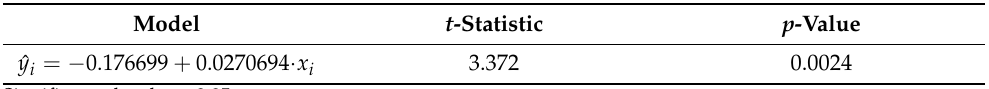
Table 5. Linear regression of precipitation change against foraged mushrooms change. Model t -Statistic Significance level α =